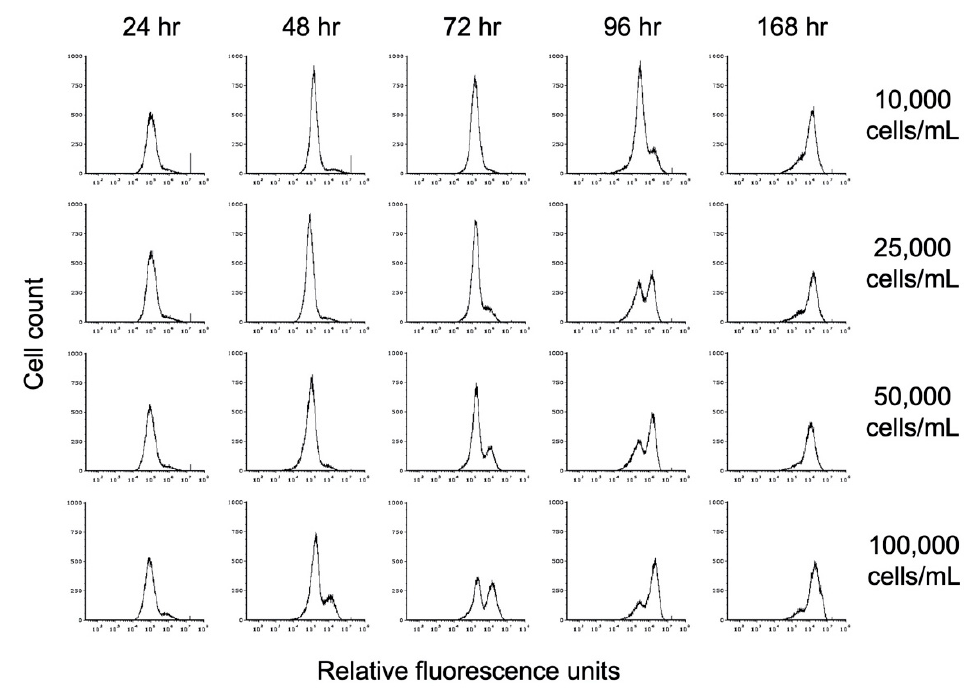
Figure 7. Effect of propionate on encystation. Replicate E. histolytica cultures inoculated at different cell densities into TYI propionate medium were harvested at 24 h intervals, stained with WGA-488, and analyzed by flow cytometry. Histograms display cell count versus relative fluorescence units and are uniform for comparison of the position and size of the peaks. Three biological replicates were performed, and the results shown are representative.